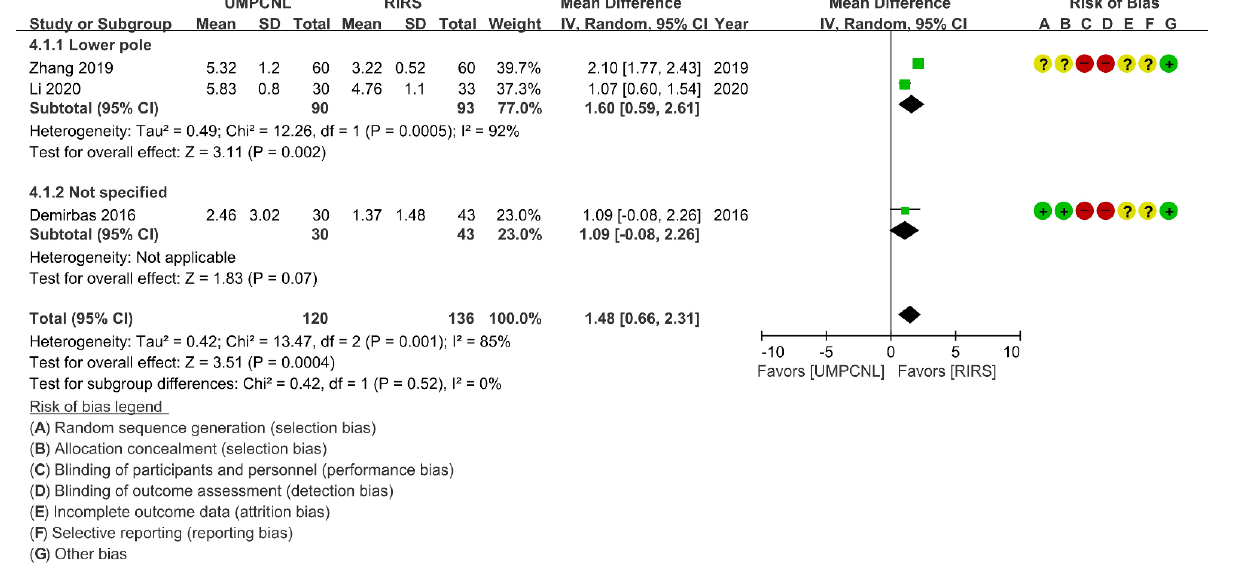
Figure 6. Comparison of UMPCNL and RIRS in terms of the hospital stay. Table 2. MINORS score in non-randomized studies included in the